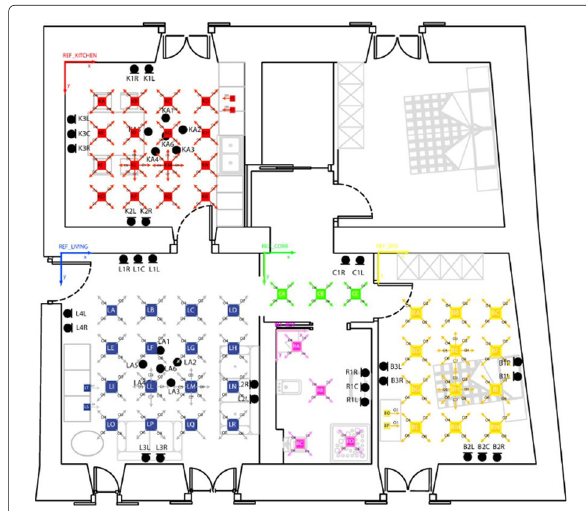
Fig. 6 Floor plan of the multi-room DIRHA apartment where the datasets of Section 7.1 are simulated or recorded. Black circles indicate the 40 microphones installed inside five rooms on their walls or ceiling. Colored squares and arrows indicate possible positions